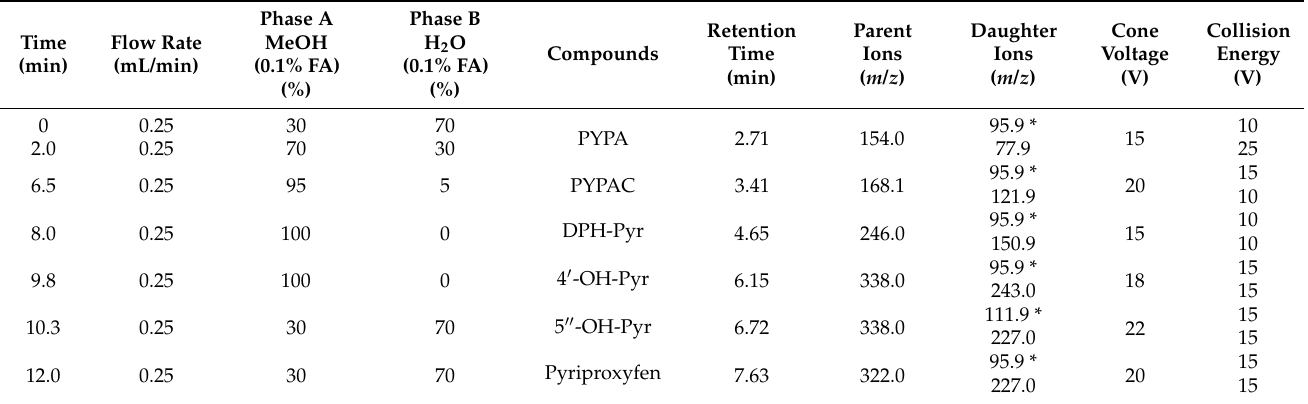
Table 1. The optimal UPLC-MS/MS analysis method for the detection of pyriproxyfen and its